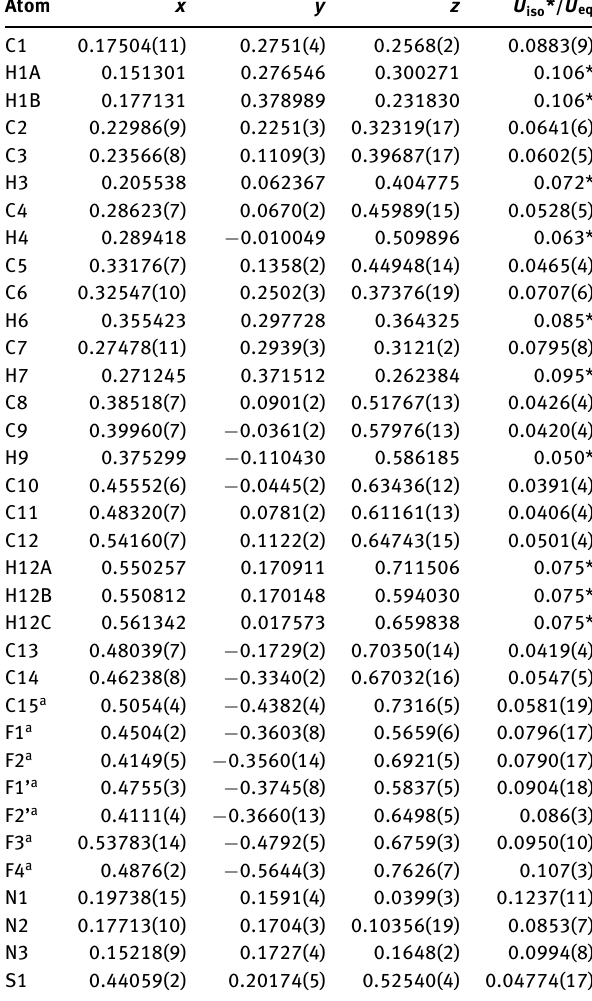
Table 2: Fractional atomic coordinates and isotropic or equivalent isotropic displacement parameters (Å 2